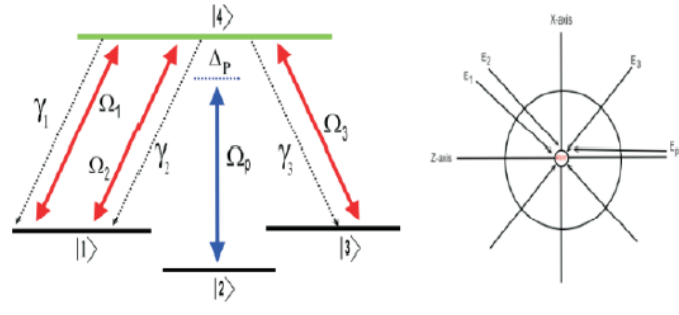
Figure 1. Scheme for four level atomic